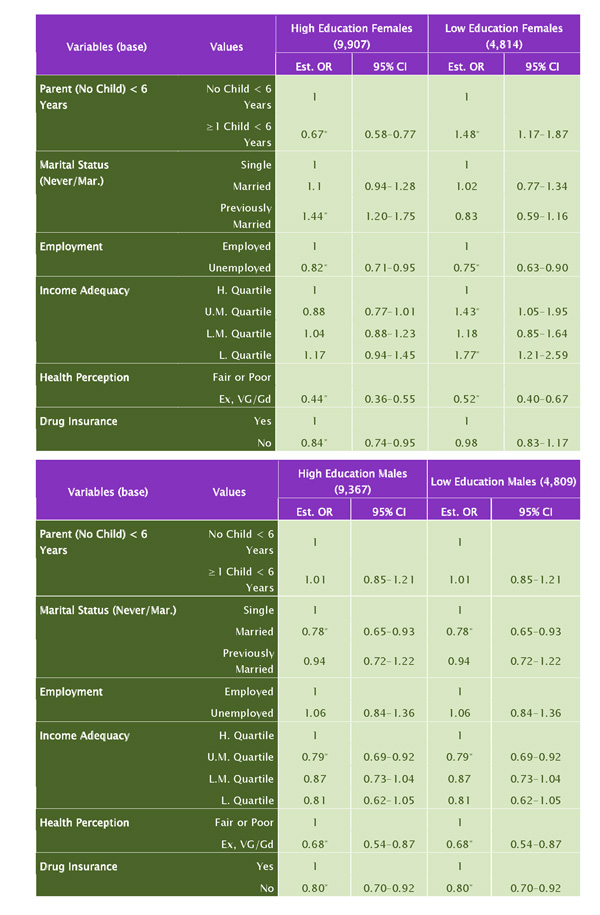
Association Between Medication (Rx and OTC) Use and Selected Social and Health Factors: Results of Logistic Regression Analysis. Source: NPHS 1996–1997 health share data (based on 2 day detailed data – Rx and OTC medication use). This sample accounts for approximately 7500 records in which the two-day detailed drug data was not coded.  "Drugs based on the ATC codes, for Stomach problems, laxatives, pain/analgesics, coughs and colds, allergies, diabetes (insulin and oral   hypo-glycaemics), cardiac conditions, hypertension (including diuretics), antibiotics, thyroid,   asthma were categorized as prescription or OTC."